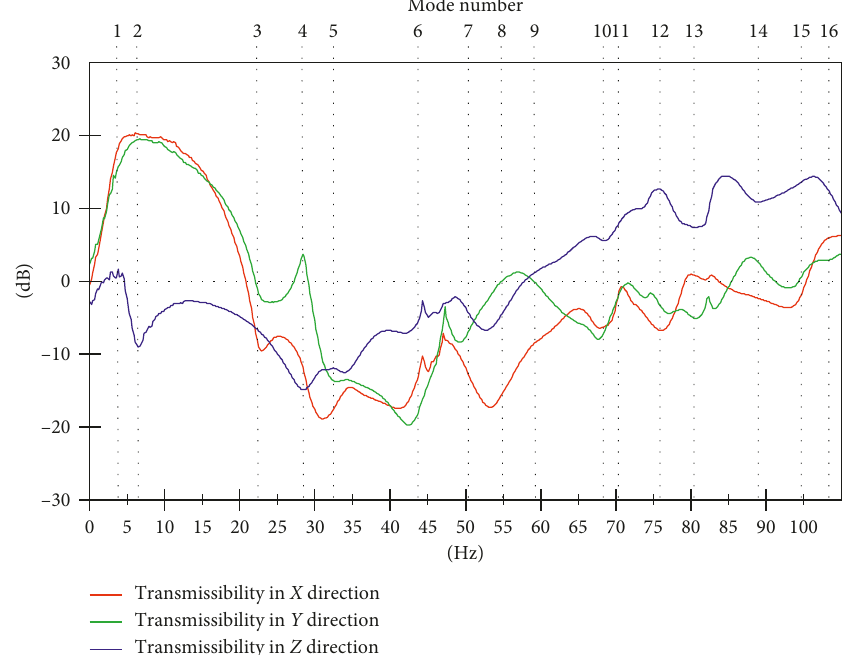
Figure 13: Transmissibility ratios in X , Y , and Z directions between the accelerometer placed in the test piece and the one mounted on the reference lens. The ratios are averaged between different excitation